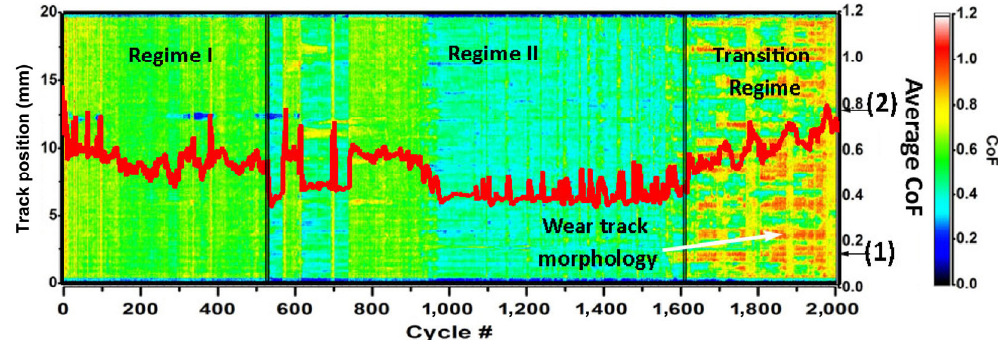
Fig. 14 Triboscopic image overlapped with average CoF at